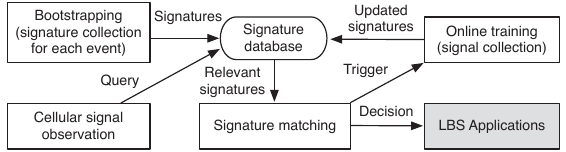
Figure 7: PRiSM operation includes three tasks: bootstrapping, signature matching, and online training.